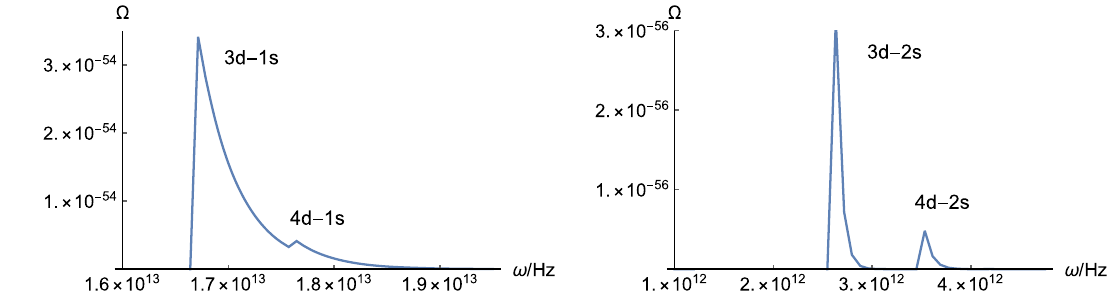
Fig. 1 The energy density spectrum of gravitational waves from spontaneous emission of hydrogen atoms